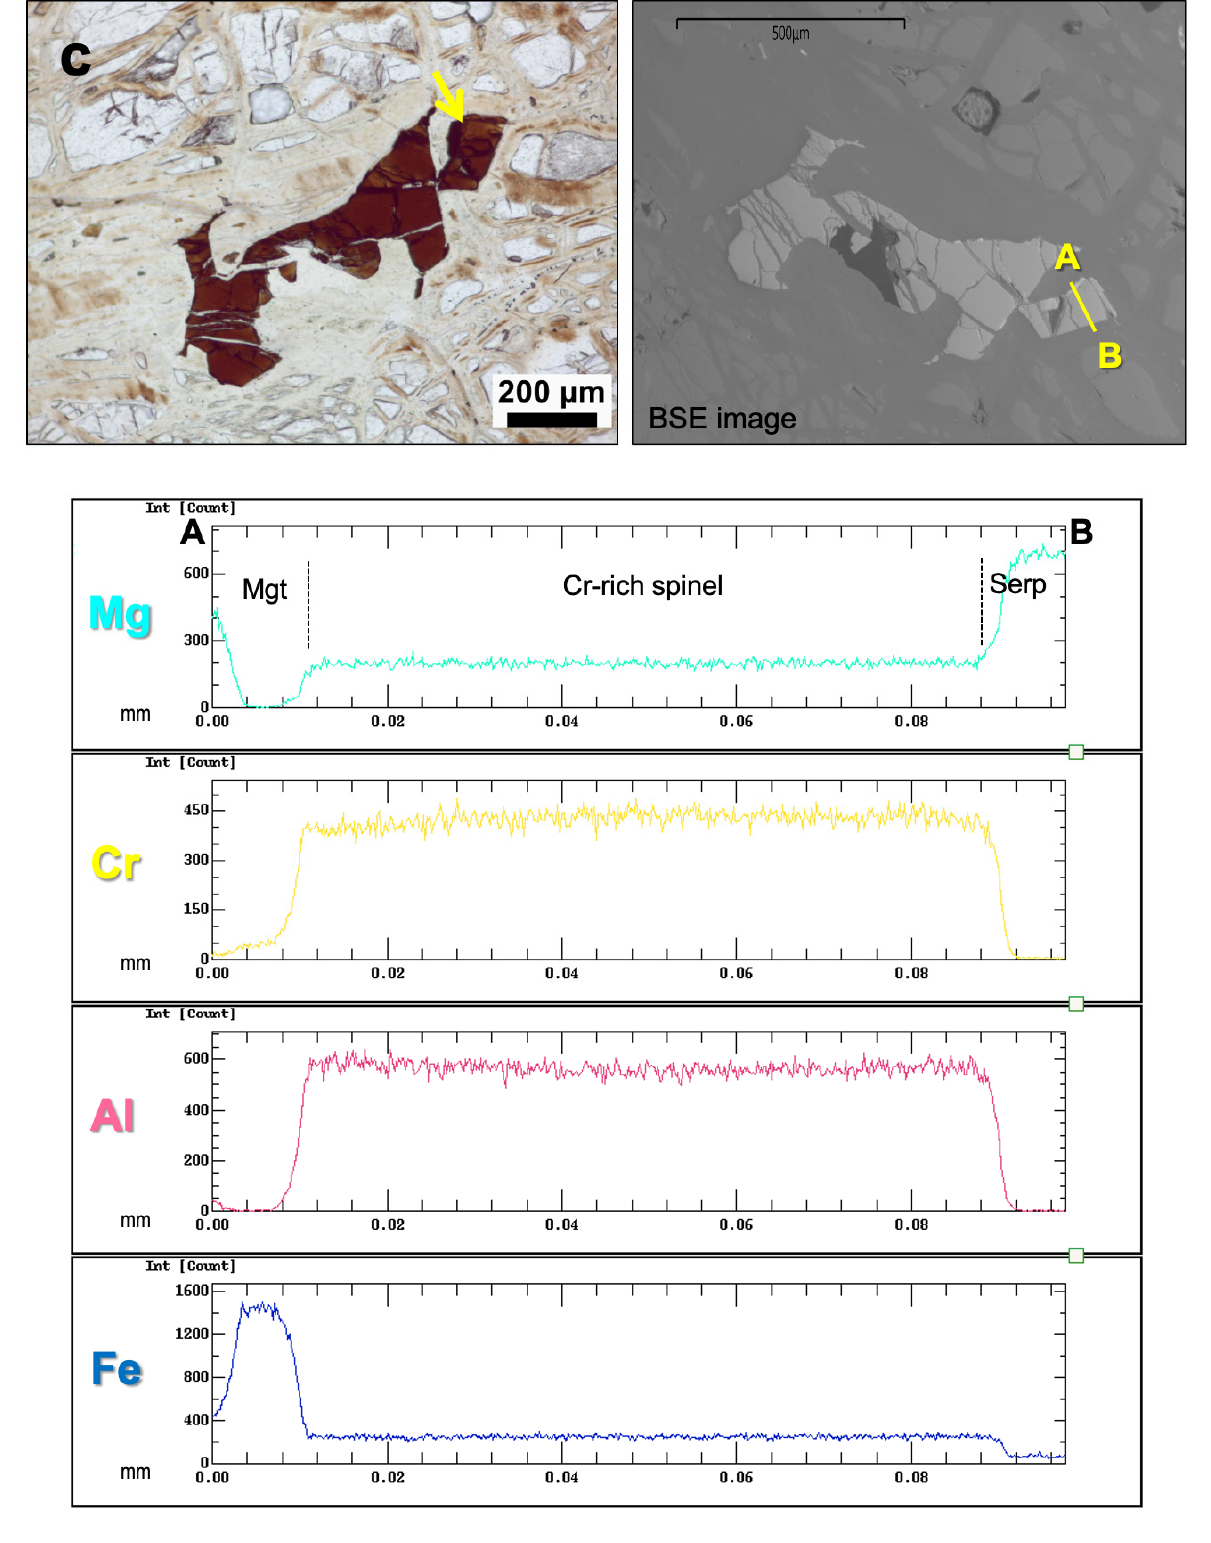
Figure 2. Transmitted-light photomicrographs, BSE images and X-ray profiles for the major components of relic chromite grains in the studied serpentinites: ( a ) well-developed opaque ferritchromit rims in anhedral chromite grains (sample FL-02-04, MAR; // pol.), with corresponding BSE image and X-ray profile on a cross-section (AB) from the wide ferritchromit rim through the